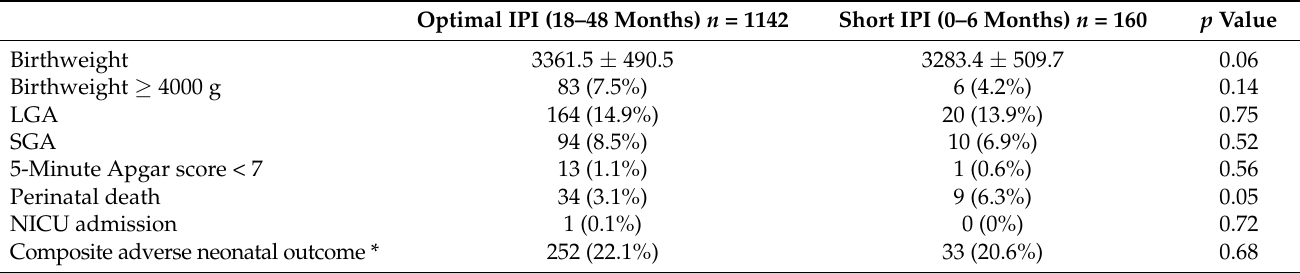
Table 3. Neonatal